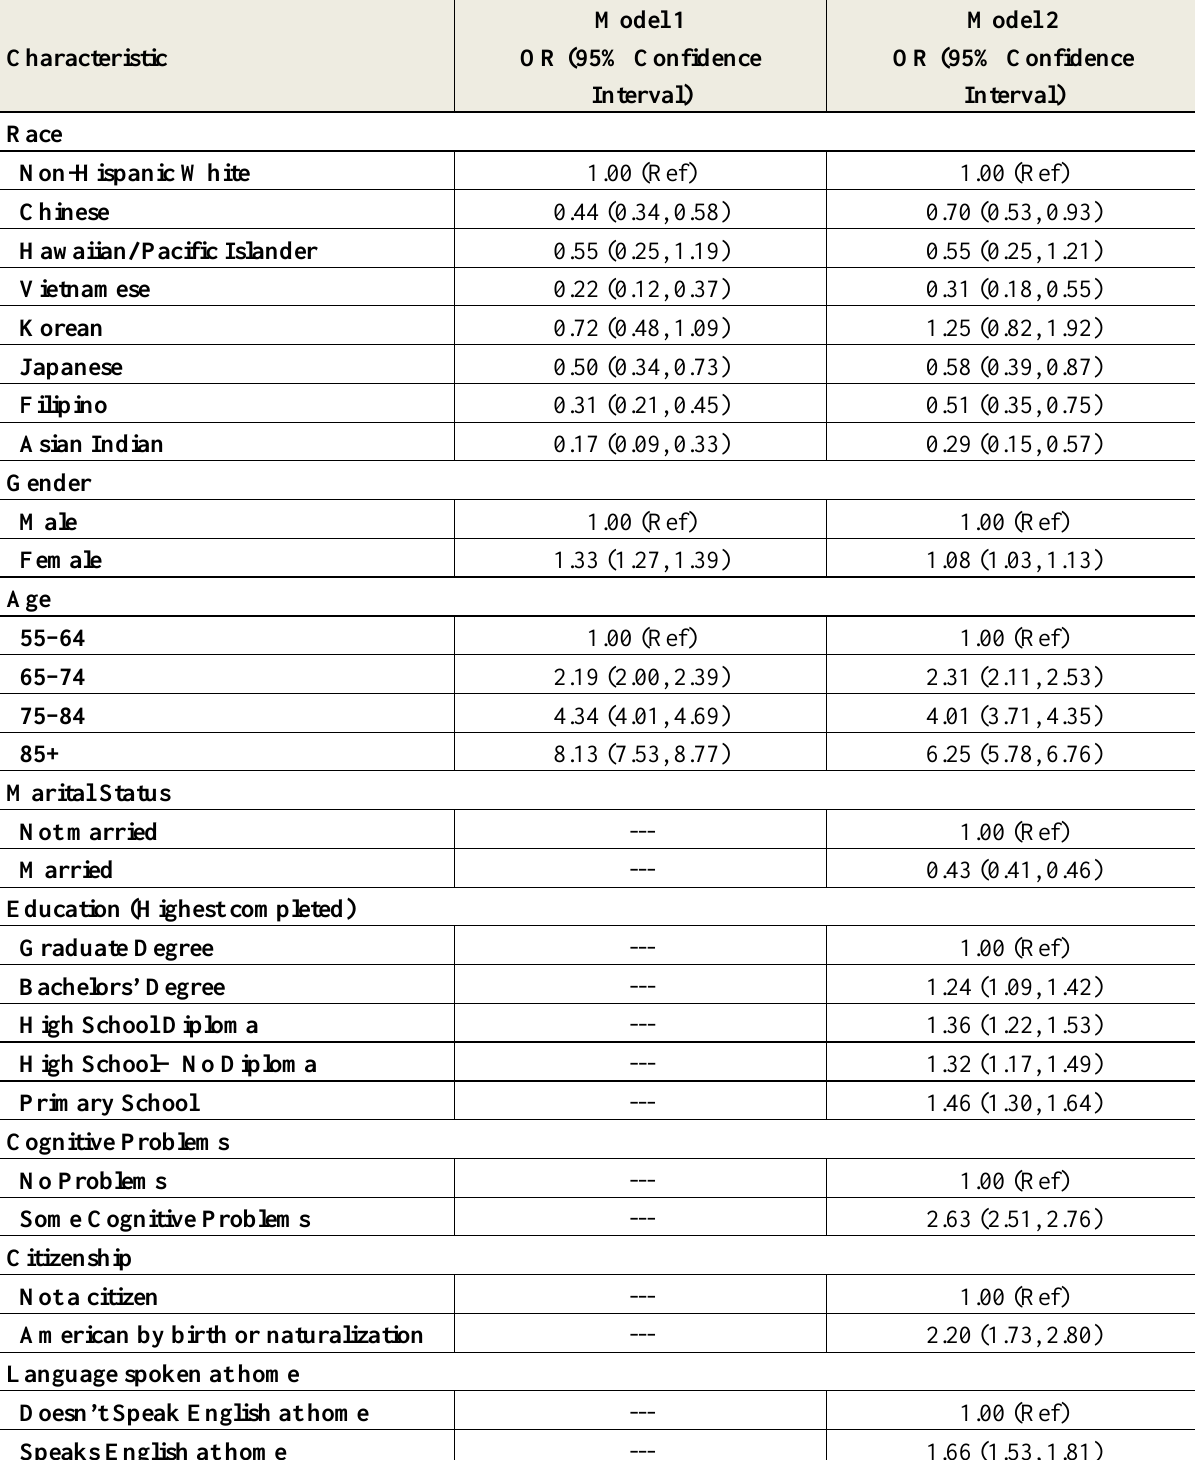
Table 2. Logistic Regression Analysis of Institutionalization among Individuals Aged 55 and over with Limitations in Activities of Daily Living. (Includes Non-Hispanic Whites and 7 AAPI Ethnicities) Source: 2006 American Community